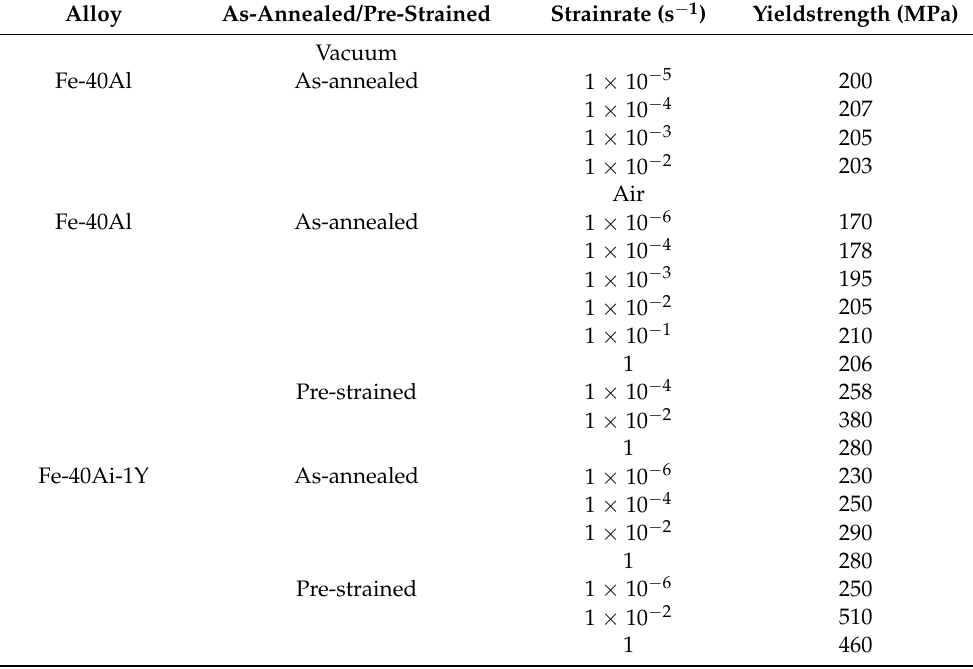
Table 2. Tensile properties of Fe-Al single crystals as a function of environment, pre-straining, and strain rate. Adapted from ref. [33]. Alloy As-Annealed/Pre-Strained Strainrate (s − 1 ) Yieldstrength (MPa) Vacuum Fe-40Al As-annealed